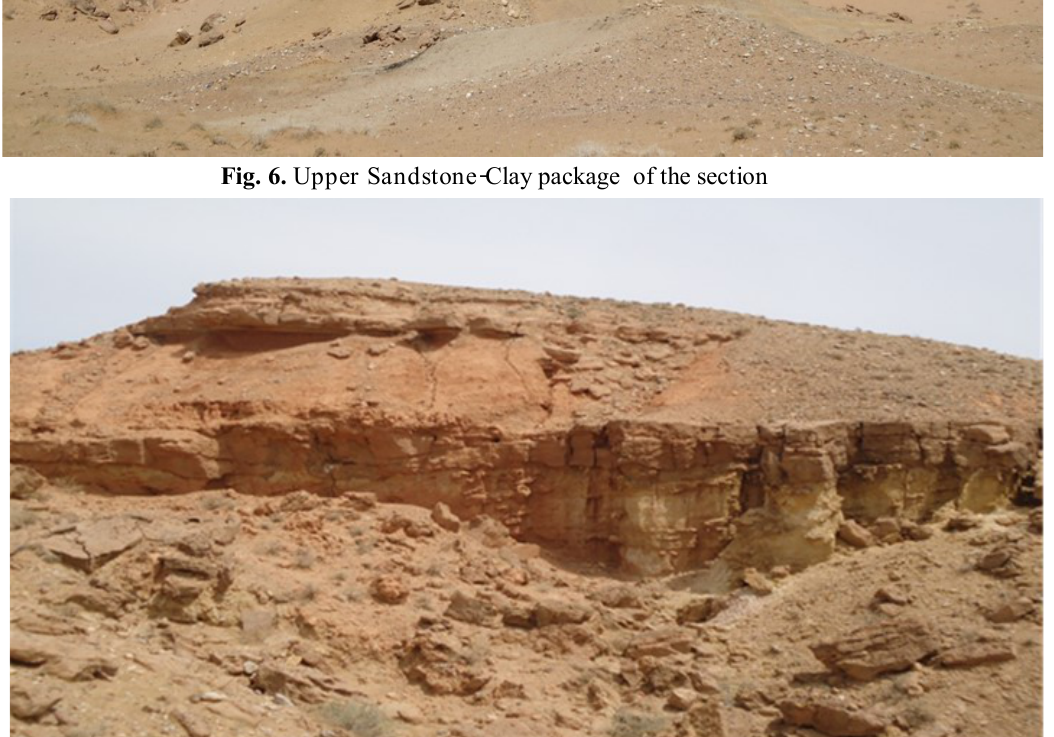
Fig. 7. View on sediment boundary that is described as existing between sediments of the Lower and Upper